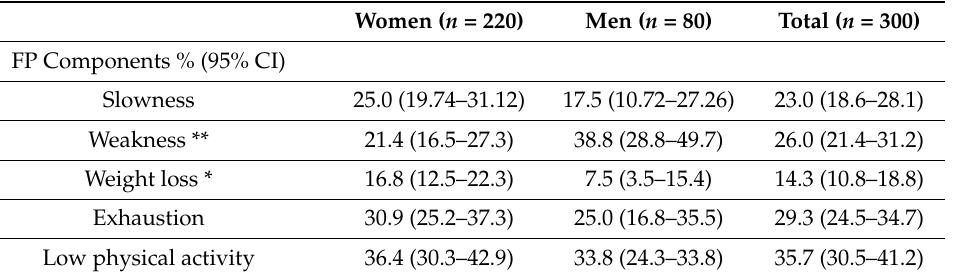
Table 2. Frequency of the frailty components of the Fried